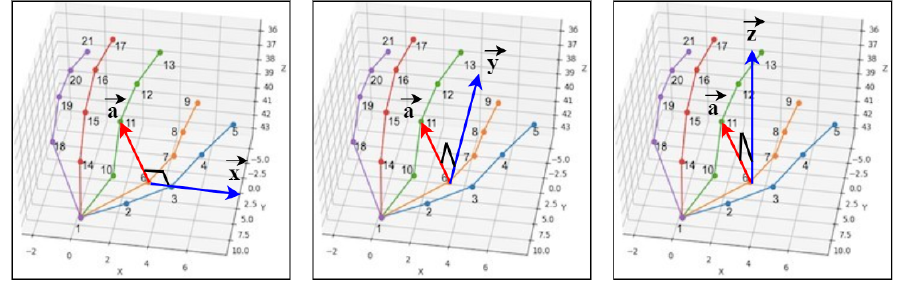
Figure 5. Calculation of angle-based features. Here, (cid:126) a is a vector created by 6th and 11th joints. After that, the angles between (cid:126) a and X-axis ( left ), Y-axis ( middle ), and Z-axis ( right ) have been calculated.